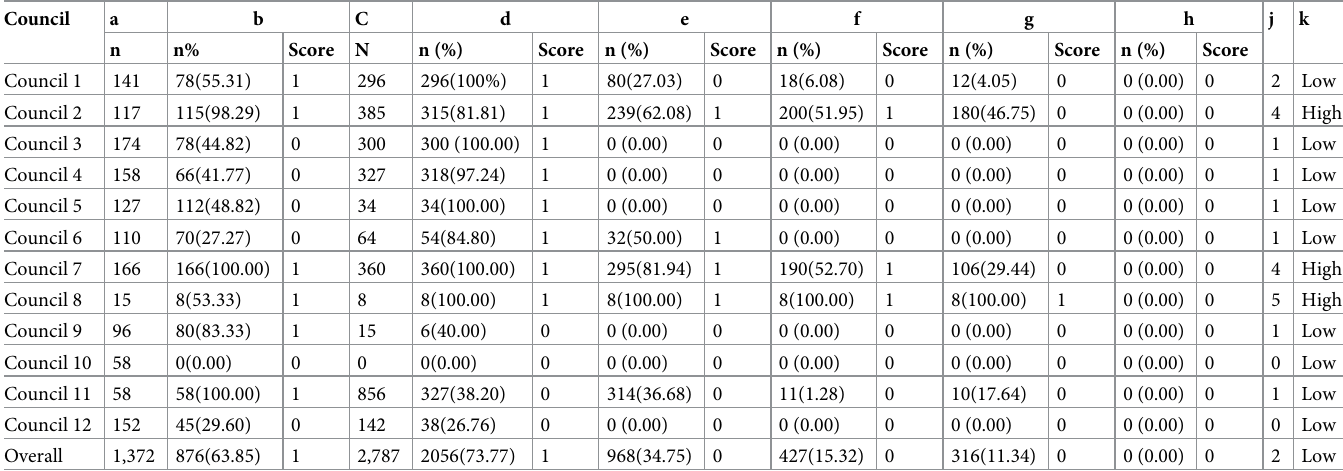
Table 3. Level of biolarviciding implementation (N = 12).